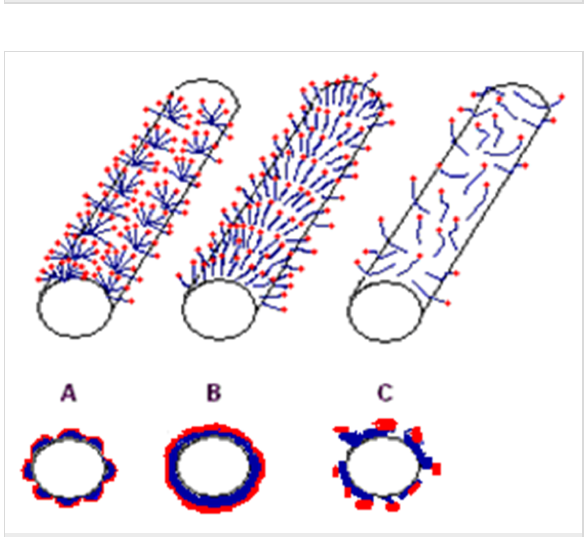
Figure 3: Schematic illustration of the different possible organizations of surfactant molecules on the surface of a CNT. Upper images refer to lateral projections; lower images refer to cross